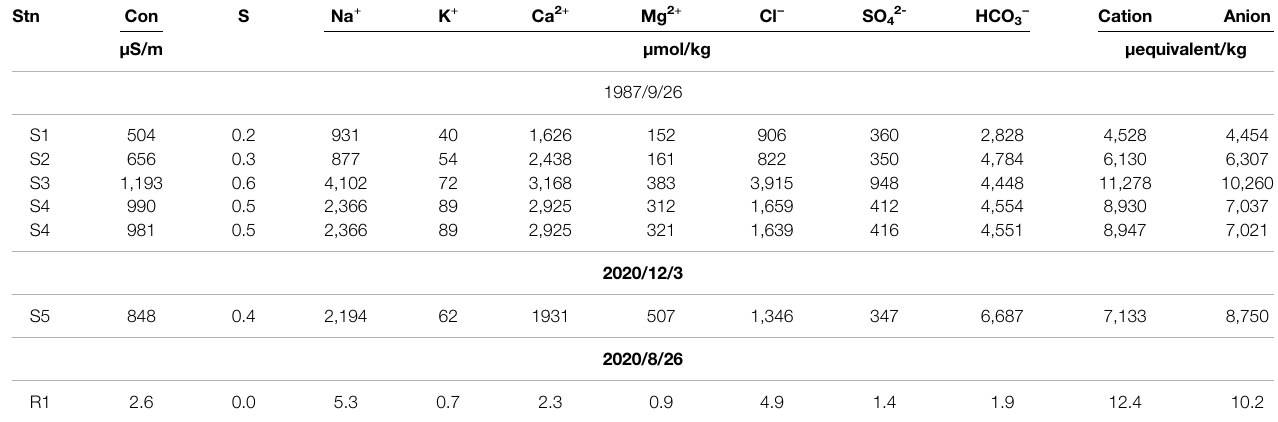
TABLE 1 | Conductivity, salinity, and the major ions of the spring waters at stations S1 – S5 and the rainwater at station R1. Stn Con